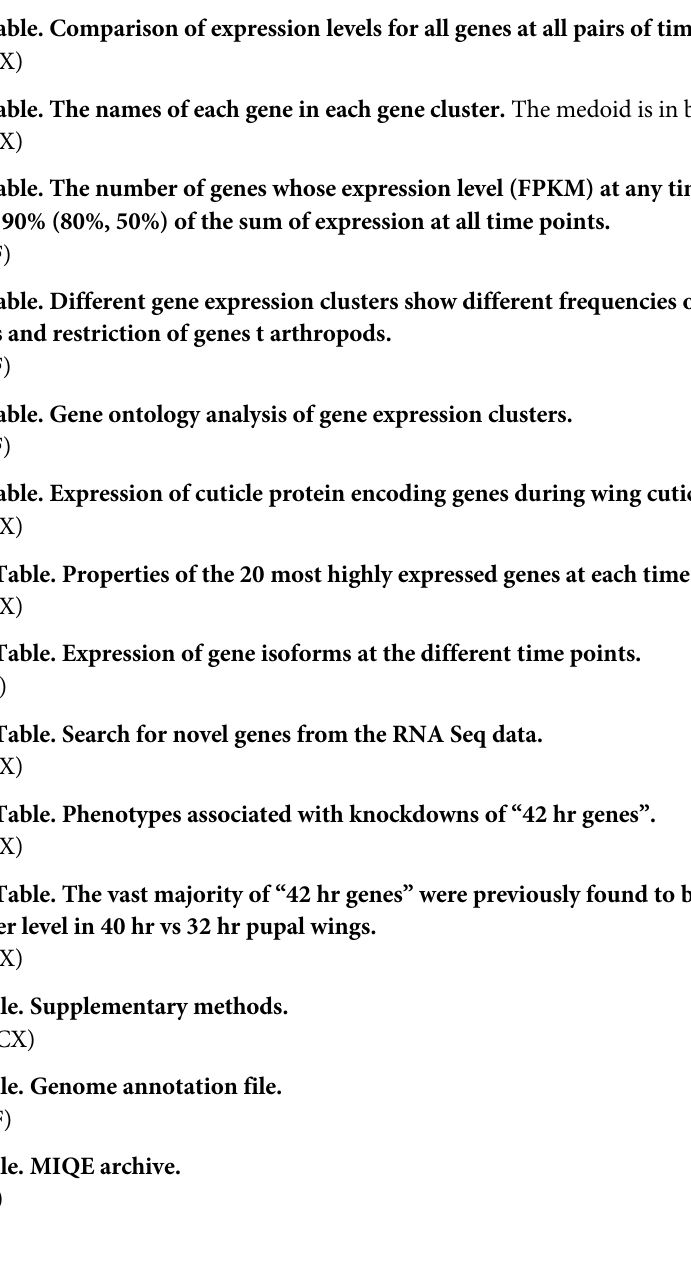
S2 Table. FPKM values for all genes at all time points. S3 Table. A comparison of the number of genes whose expression changed between neigh- boring time points. S4 Table. Comparison of expression levels for all genes at all pairs of time points. S5 Table. The names of each gene in each gene cluster. The medoid is in bold. S6 Table. The number of genes whose expression level (FPKM) at any time point is greater than 90% (80%, 50%) of the sum of expression at all time points. S7 Table. Different gene expression clusters show different frequencies of mutant pheno- types and restriction of genes t arthropods. S8 Table. Gene ontology analysis of gene expression clusters. S9 Table. Expression of cuticle protein encoding genes during wing cuticle deposition. S10 Table. Properties of the 20 most highly expressed genes at each time point. S11 Table. Expression of gene isoforms at the different time points. S12 Table. Search for novel genes from the RNA Seq data. (XLSX) S13 Table. Phenotypes associated with knockdowns of “ 42 hr genes ” . S14 Table. The vast majority of “ 42 hr genes ” were previously found to be expressed at a higher level in 40 hr vs 32 hr pupal